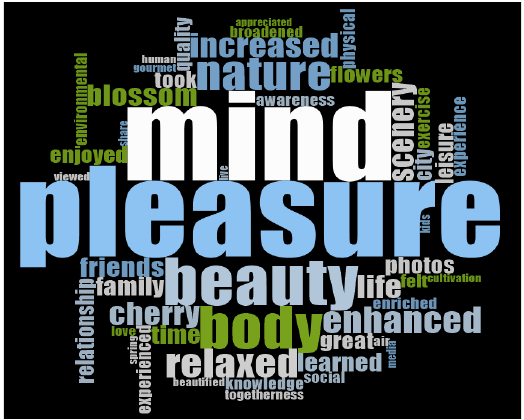
Figure 5. Stated benefits by locals.